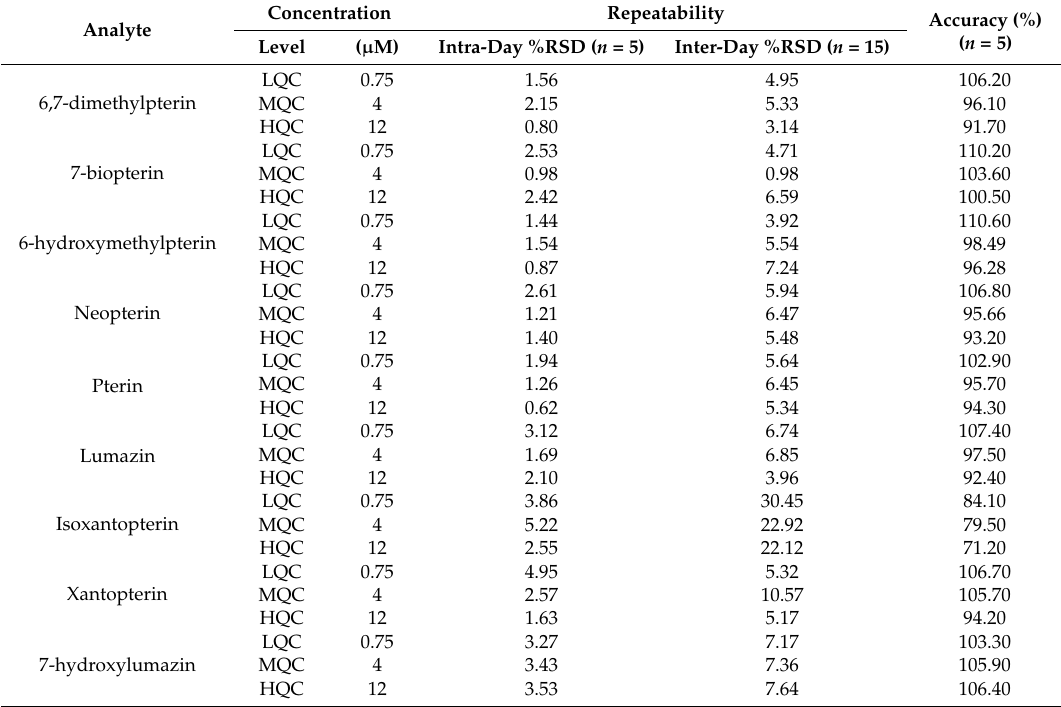
Table 2. Intra-day and inter-day repeatability and precision measured at low, medium, and high concentration